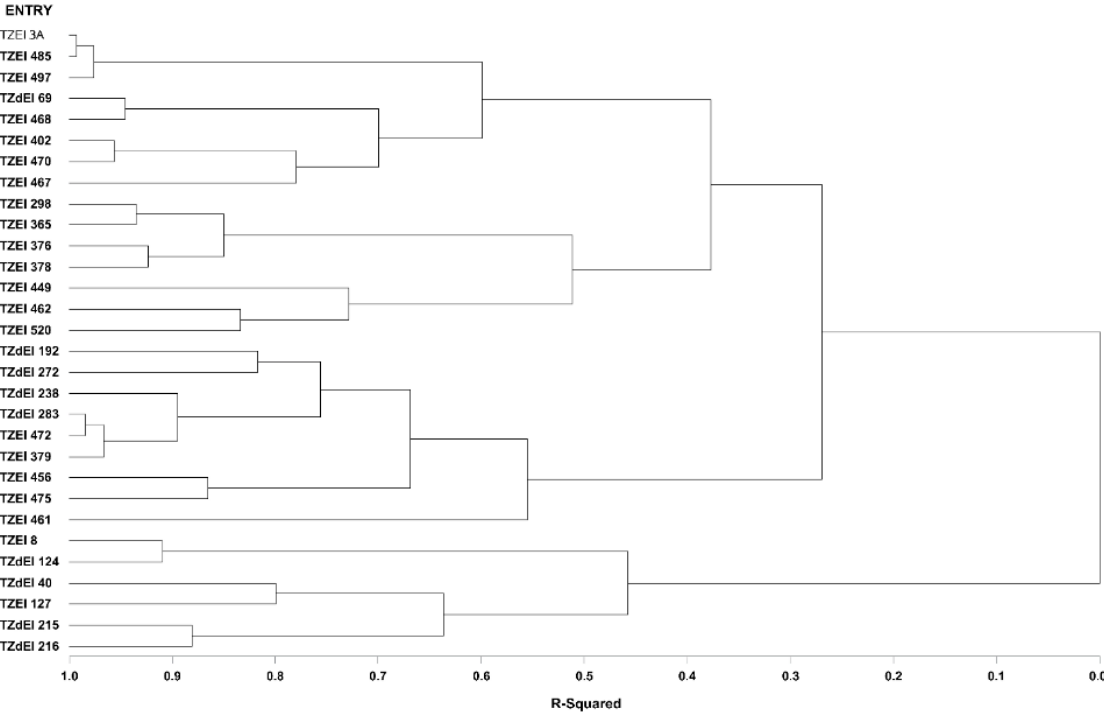
Figure 3. Dendrogram of thirty early maturing maize inbred lines obtained using Ward’s minimum variance cluster analysis based on the HGCAMT method across eight Striga -infested and optimal environments, 2016 and 2017.